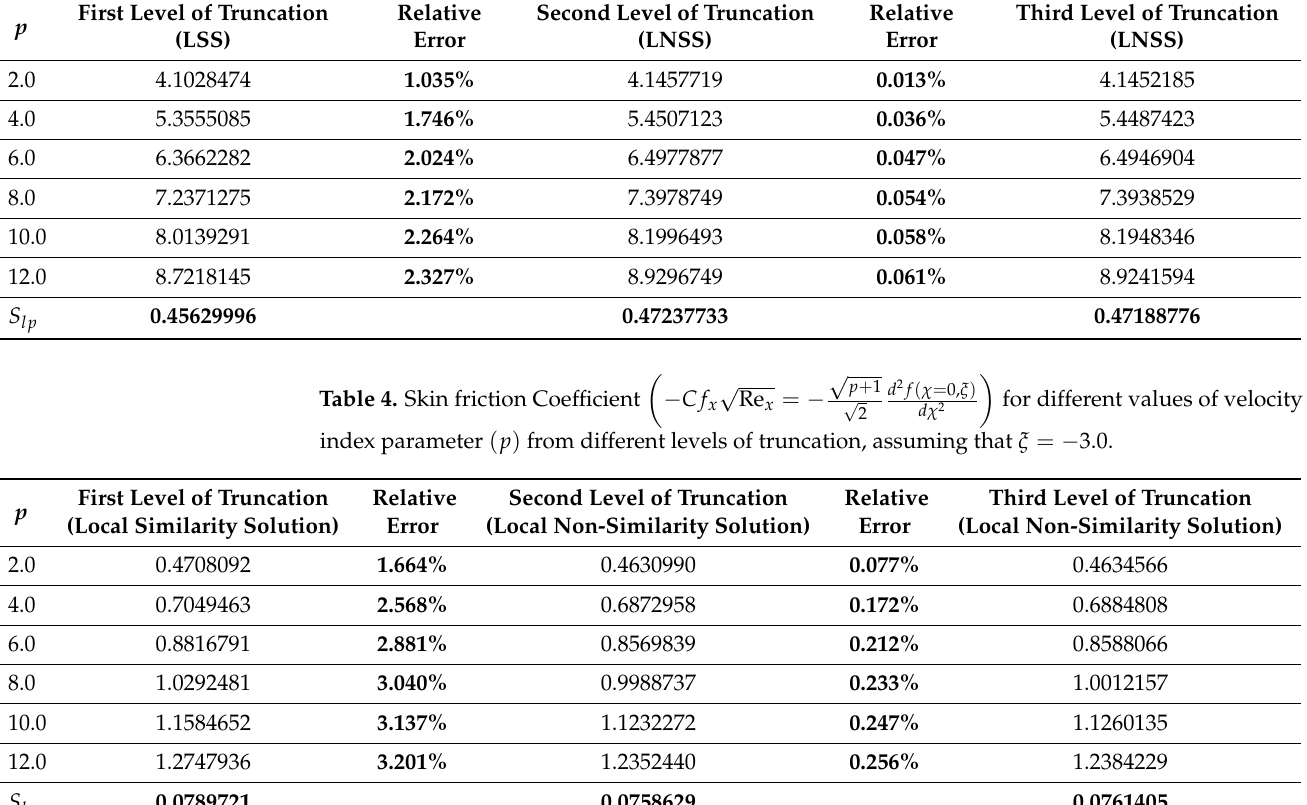
Table 3. Skin friction Coefficient index parameter ( p ) from different levels of truncation, assuming that ξ = 3.0.